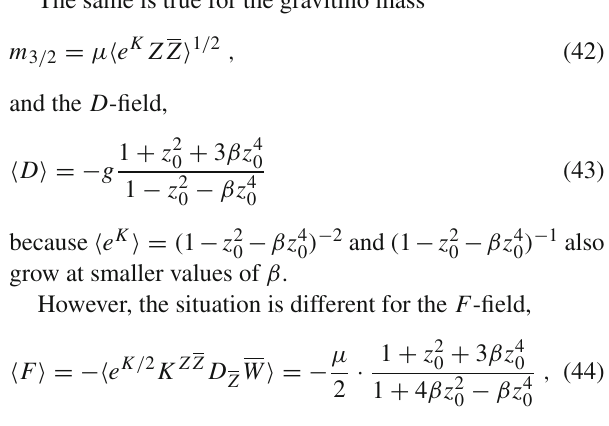
Fig. 5 Thescalarpotential(7) + (8)forthecanonicalinflaton ϕ ( α = 2) and different values of β and ω , compared to the α -attractor (39). The canonical inflaton is shifted, ϕ → ϕ − | ϕ 0 | , so that the minimum is at ϕ = 0